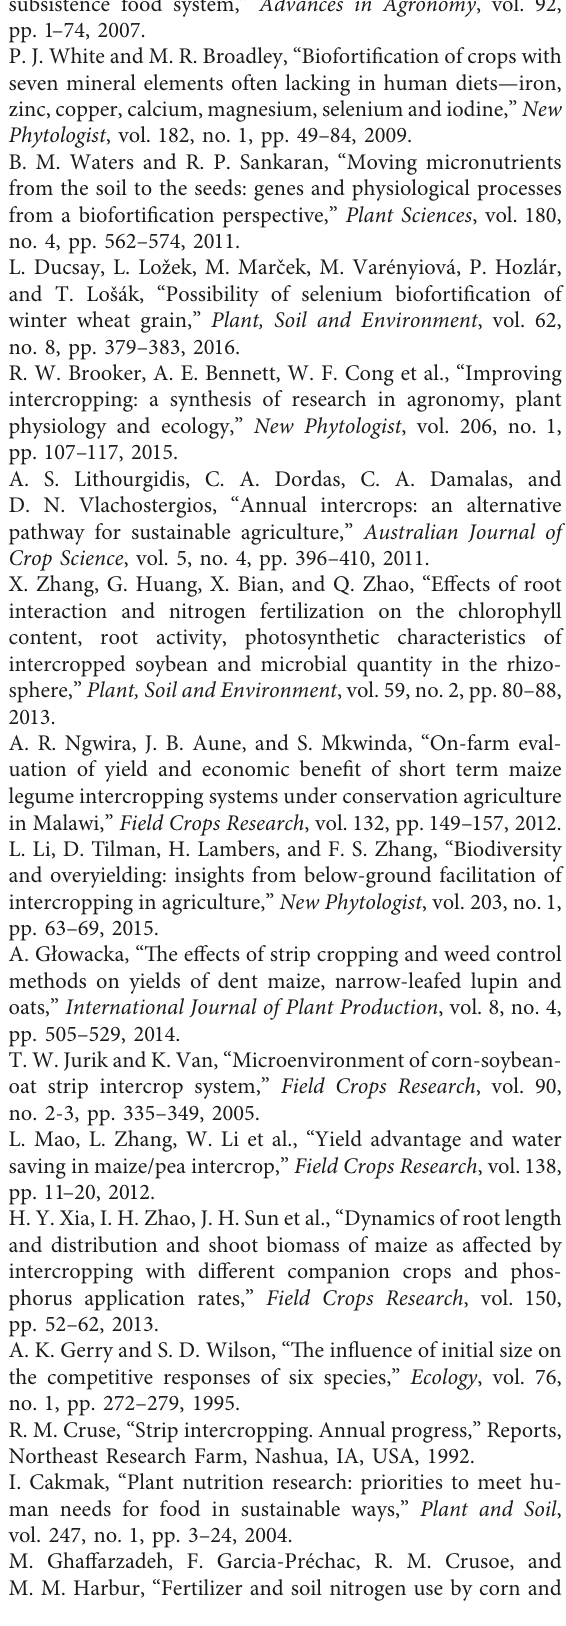
Table 6: The amount of nutrients supplied by maize silage at a dose of 16kg · d.m. (in g) and the percentage of covering the cow’s de- mand for these